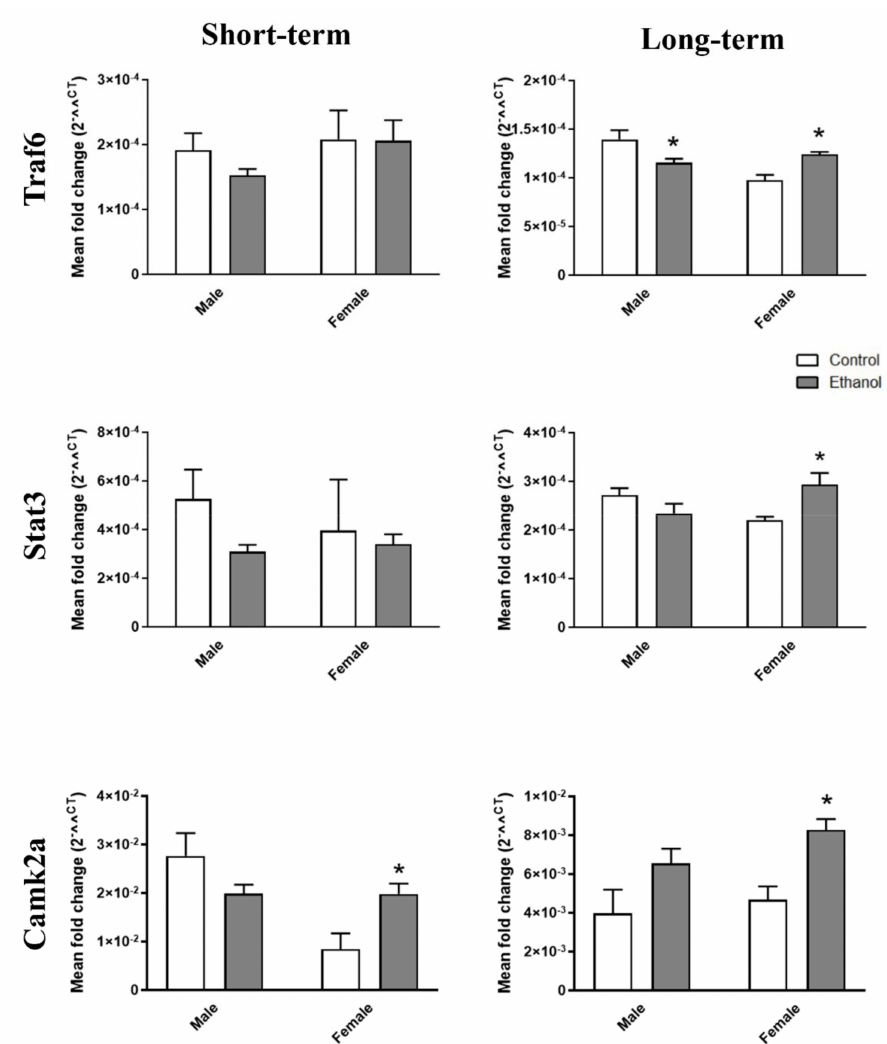
Figure 6. E ff ects of ethanol on the target gene profile of mir-146a-5p and mir-21-5p in the cerebral cortices of adolescent WT mice. Graphs represent the expression of Traf6, Stat3, and Camk2a after a 24-h and 2-week withdrawal period of ethanol or saline treatment in the female and male adolescent WT mice (PND 44 and PND 58). Data represent mean ± SEM, n = 6 independent experiments. * p < 0.05 compared to their respective control counterparts, according to the two-way ANOVA followed by the Bonferroni post hoc